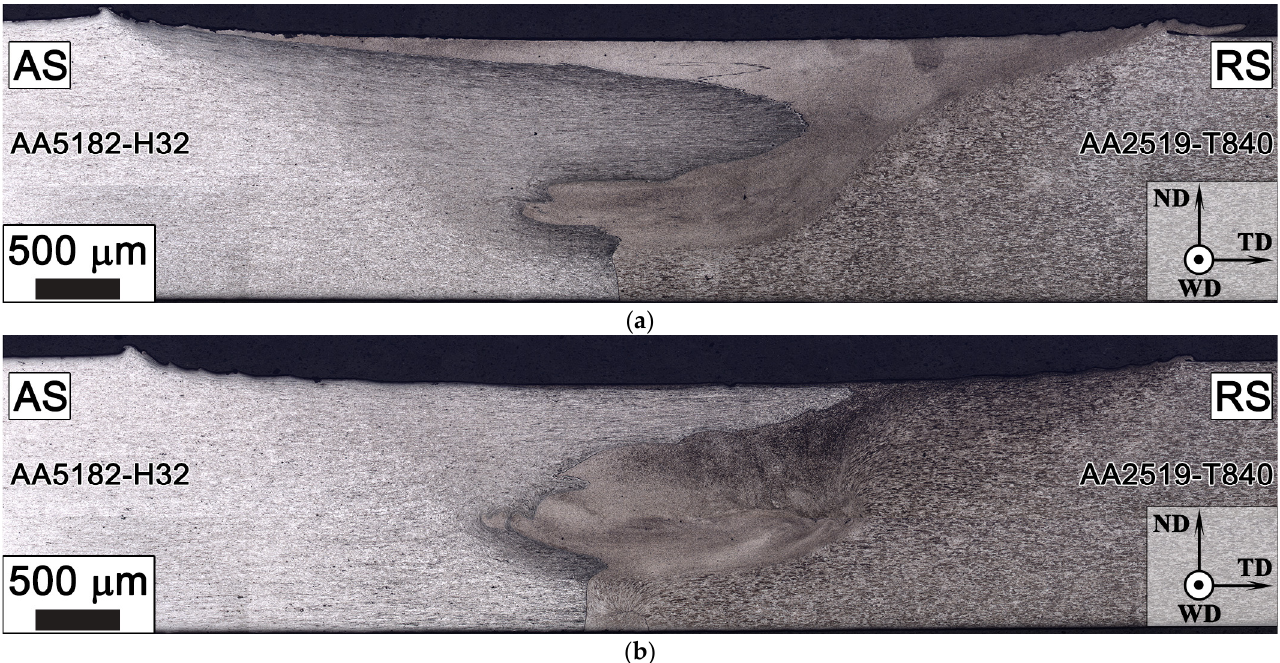
Figure 2. Macroscopic photograph of the dissimilar FSW joints.